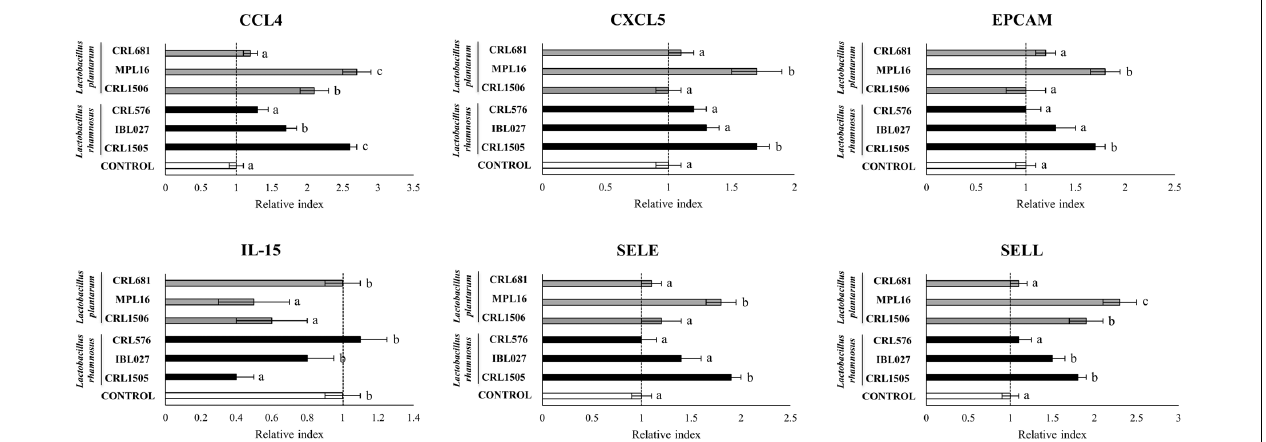
FIGURE 2 | Expression of chemokines [interleukin 15 ( IL-15 ), CCL4 , and CXCL5 ] and adhesion molecules ( EPCAM , SELE , and SELL ) genes in porcine intestinal epithelial (PIE) cells treated with Lactobacillus rhamnosus CRL1505, L. rhamnosus IBL027, L. rhamnosus CRL576, Lactobacillus plantarum CRL1506, L. plantarum MPL16, or L. plantarum CRL681 and challenged with the viral molecular–associated pattern poly(I:C), analyzed by quantitative polymerase chain reaction. Porcine intestinal epithelial cells with no lactobacilli treatment and stimulated with poly(I:C) were used as controls. The results represent data from three independent experiments. Letters indicate significant differences ( P < 0.05), a < b < c.